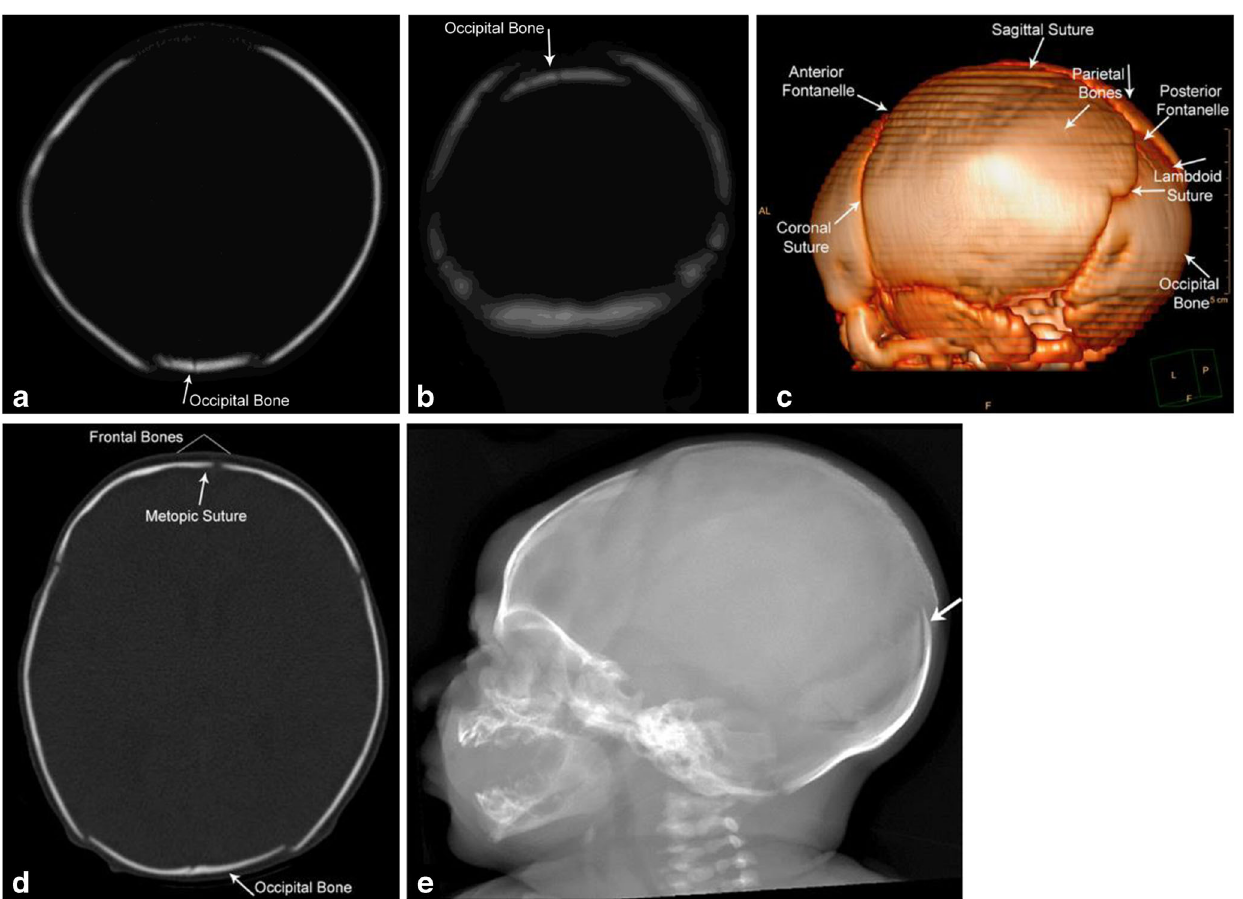
Fig. 5 Molding of the skull post vaginal delivery Immediate post- delivery appearances of the skull on head CT. The occipital bone is slightly depressed with associated sutural overlap as seen on the axial